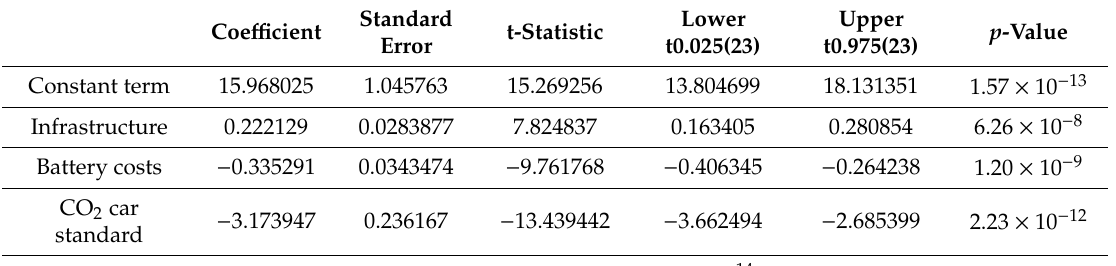
Table 7. The results of multiple regression for electricity consumption by cars in the EU in 2030. Standard Lower Upper p Coe ffi cient t-Statistic Error t0.025(23) t0.975(23)